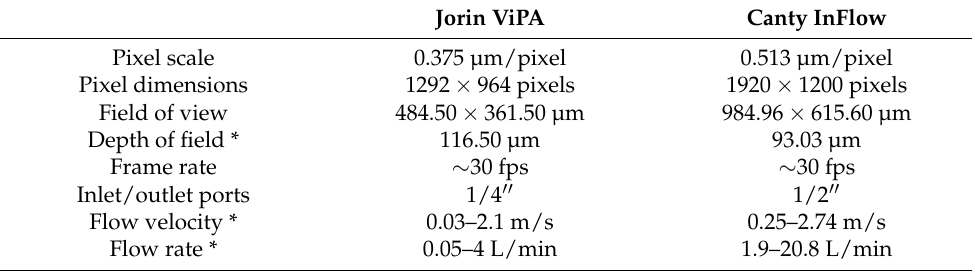
Table 1. Execution specifications of both microscopes.